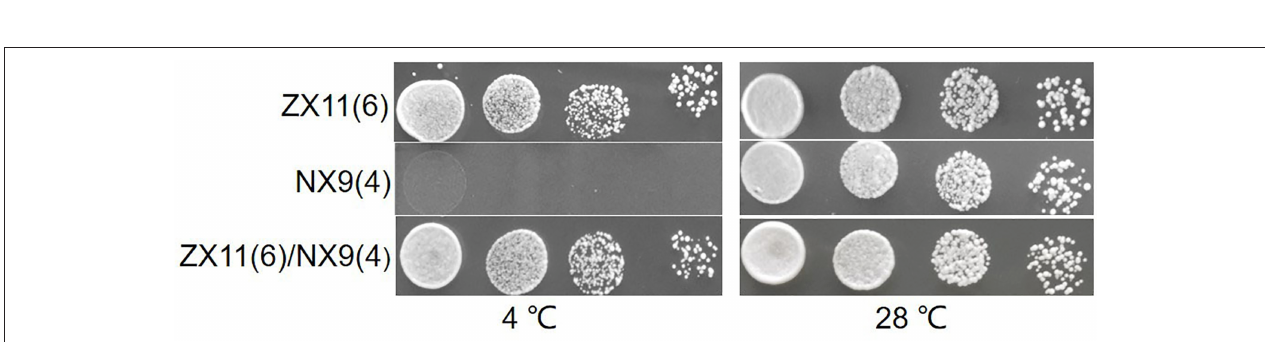
FIGURE 2 | The distribution of the µ max in the haploid ho segregants of ZX11 and NX9 at 4 ◦ C. The ZX11 segregant, ZX11(6), that displayed the highest µ max value (0.0132) in all segregants at 4 ◦ C, was chosen as the superior parent strain. A NX9 segregant, NX9(4) only grew slightly with the µ max value of 0.0025, was used as the inferior parent strain.